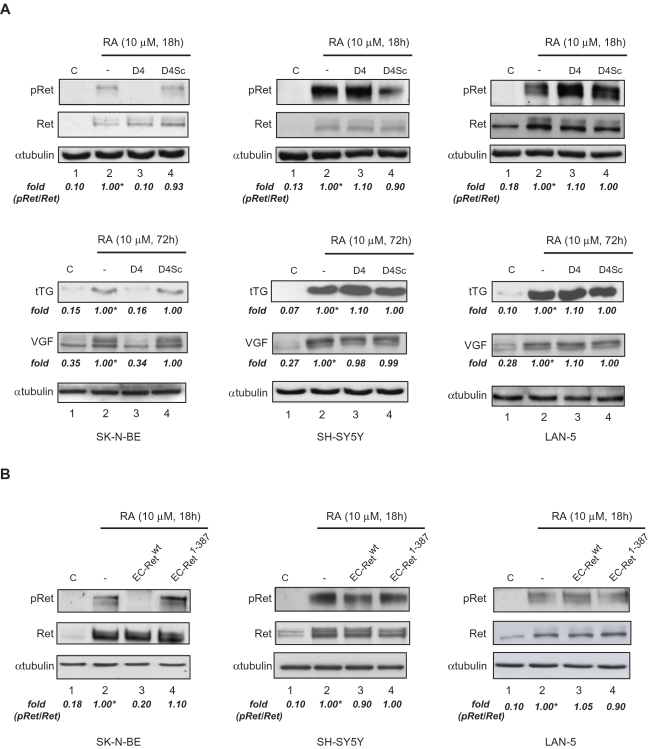
The RA-induced stimulation of Ret activity is GDNF-independent in SH-SY5Y and LAN-5 cells.(A) SK-N-BE (left panels), SH-SY5Y (middle panels) and LAN-5 (right panels) cells were left untreated (lane 1) or treated for the indicated incubation times with RA either in the absence (lane 2) or in the presence of D4 (lane 3) or D4sc (lane 4). Cell lysates were immunoblotted with anti-pRet, anti-Ret, anti-tTG or anti-VGF antibodies. Equal loading was confirmed by immunoblotting with anti-αtubulin antibodies. (B) SK-N-BE (left panels), SH-SY5Y (middle panels) and LAN-5 (right panels) cells were incubated either in the absence (lane 2) or in the presence of ECRetwt (lane 3) or EC-Ret1-387 (lane 4) as indicated. Lanes 2 to 4, treatment with RA. Cell lysates were immunoblotted with anti-pRet or anti-Ret and and to confirm equal loading the filters were stripped and reprobed with anti-αtubulin? antibodies. In (A) and (B), quantitations were done as reported in legend to Figure 1A and relative abundances are expressed relative to controls, arbitrarily set to 1. Blots shown in (A) and (B) are representative of at least three independent experiments.